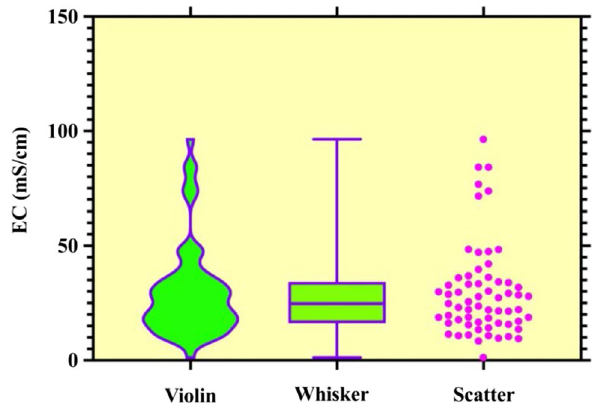
Fig. 7 Distribution of EC in the samples